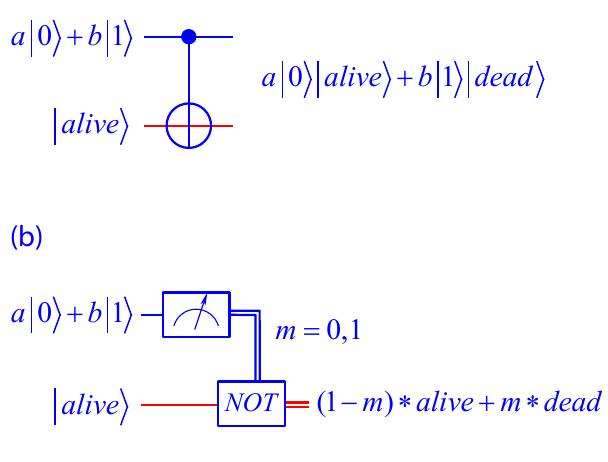
Figure 1: The quantum network model reveals the information flow in the thought experiment. Single lines represent quan- tum systems (qubits) and double lines classical systems (bits); blue (red) lines denote the atom (cat). Quantum (classical) information flows along the single (double) lines. (a) Quantum network entangling the atom and the cat. A quantum cat in the initial state | ali v e (cid:105) is coupled to the atom via a quantum CNOT gate resulting in the state a | 0 (cid:105)| ali v e (cid:105) + b | 1 (cid:105)| dead (cid:105) . (b) Quantum network for the standard setup of Schr¨odinger’s cat. The atom evolves freely to a | 0 (cid:105) + b | 1 (cid:105) and is coupled to the cat via a classical information channel: if the detector clicks (m = 1 ), a poison is released and kills the